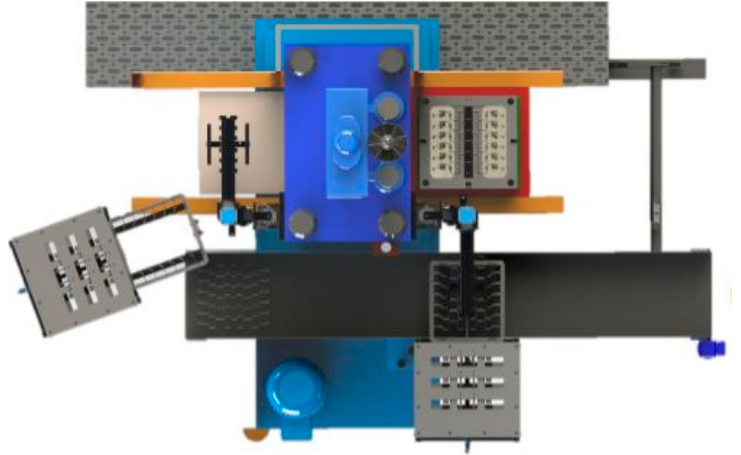
Figure 11. Top view of the final layout of the injection machine already provided with the feeding and extracting system, as well as the conveyor belt. and extracting system, as well as the conveyor